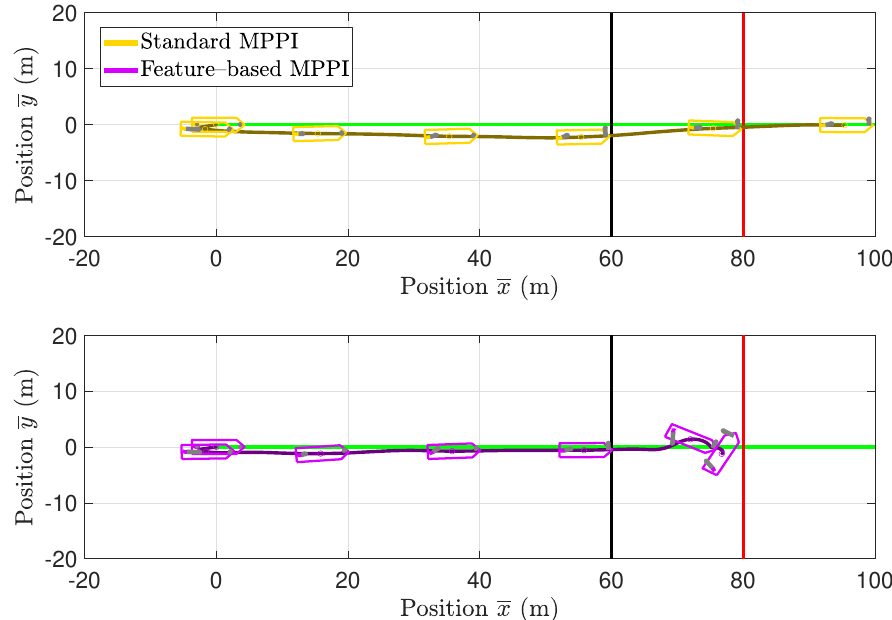
Figure 5. Comparison of the resulting trajectories of the vessel in the simulation environment. While the upper plot shows the performance of standard MPPI control, the lower plot shows the performance of the feature–based MPPI control approach. Both plots use transformed coordinates calculated by (30). The green lines visualize the reference trajectories in both plots. After passing the black line, the vessel detects the obstacle visualized as a red